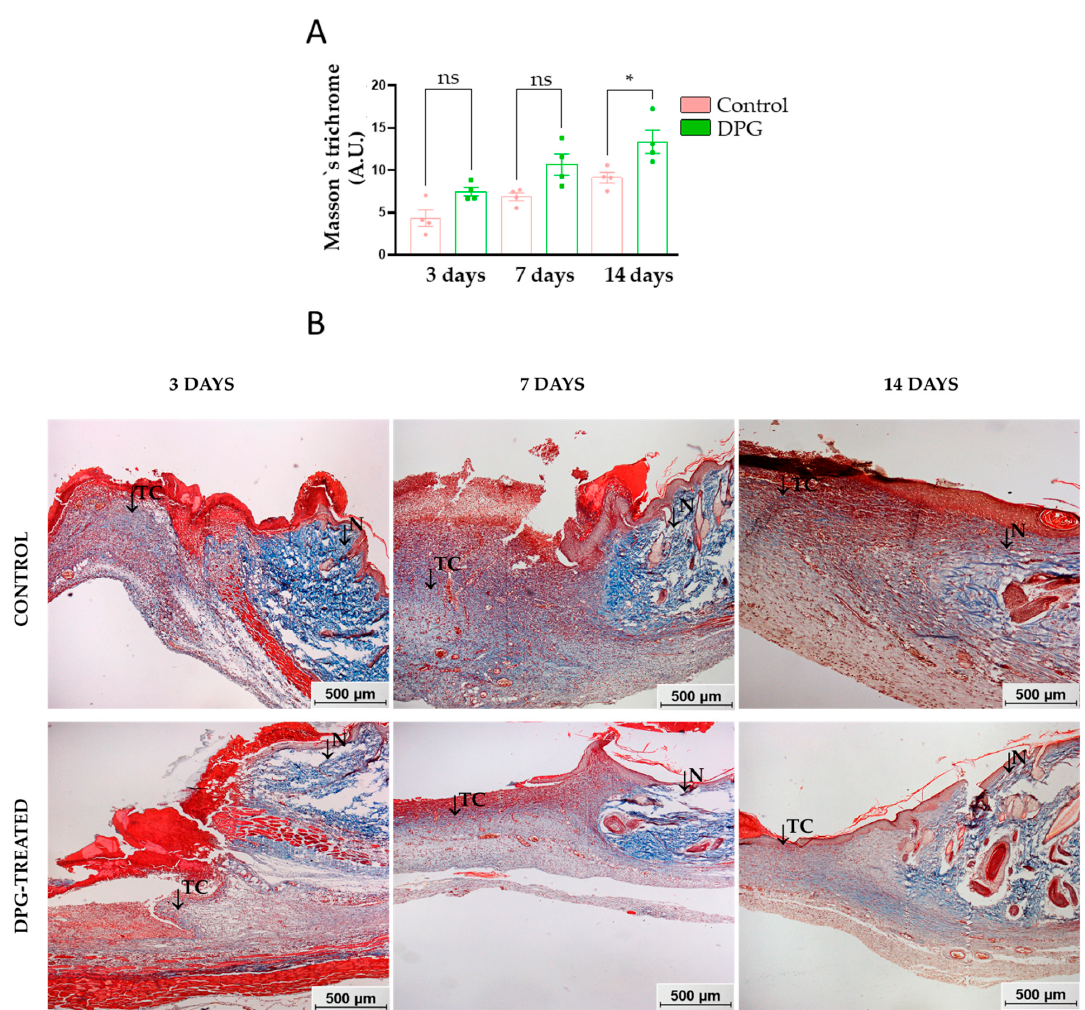
Figure 3. ( A ) Quantitative pixel density evaluation of total collagen content in wound scar areas over days 3, 7, and 14 of experimentation, DGP vs. Control, day 14 (* p < 0.05). ( B ) Representative histological images of the wound scar areas of the animals, both untreated and treated with DPG, throughout the experimentation period. Note that the presence of normal tissue (N) and the presence of total collagen (TC) is highlighted. TM staining: 50 × magnification (bar = 500 µ